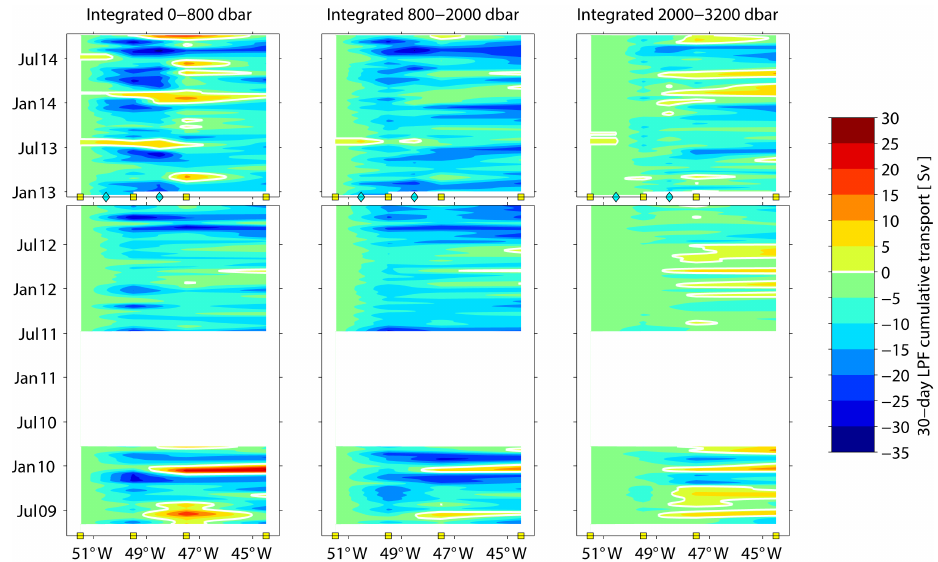
Figure 5. Hovmoller plots illustrating the 30-day low-pass-filtered (LPF) meridional absolute transports integrated in three layers as noted in the panel titles. Transports are cumulatively integrated offshore from the shallowest site eastward toward the center of the basin. Bold white contour indicates zero meridional flow. Symbols along the bottom axes indicate the location of the PIESs and CPIESs; the upper panels show the time periods when all six sites were available.